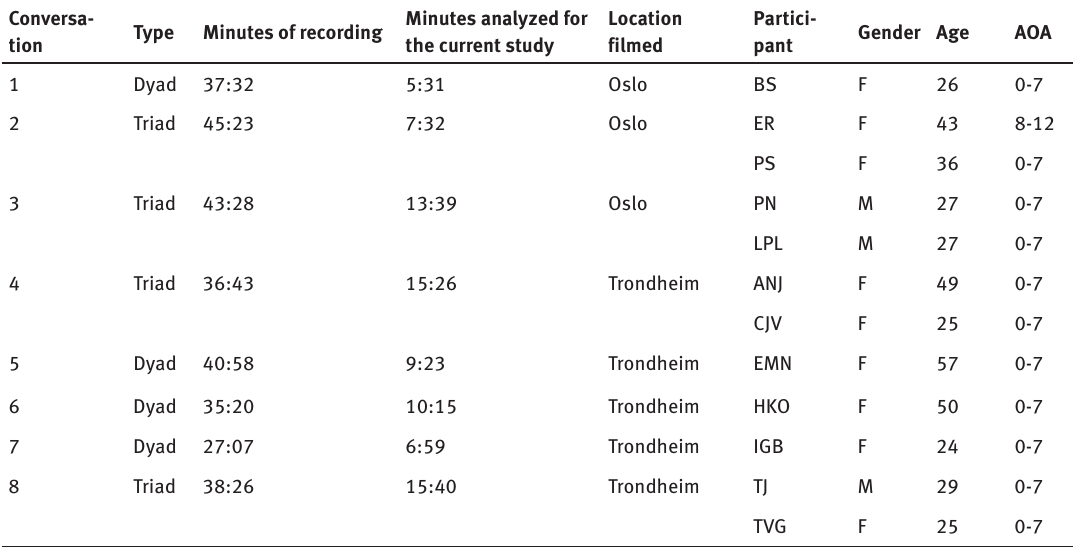
Table 1: Summary of study corpus.